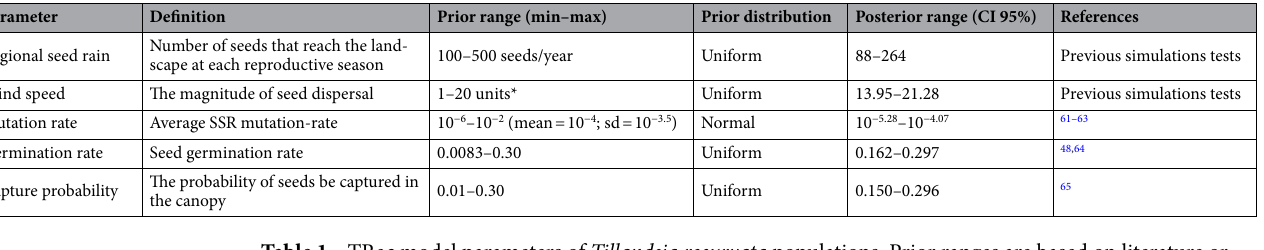
trees/ha (Fig. 5A). The simulations also showed a tendency of convergence in the proportion of ground cover (ca. 100%; Fig. 5B) and MLL abundance of T. recurvata populations (ca. 140 MLLs; Fig. 5D) among such distinct scenarios after the first 60 years following the tree density changes. Populations from deforested and reforested landscapes, however, showed distinct patterns of individual abundance (Fig. 5C). While T. recurvata populations from deforested landscapes increased up to ca. 600,000 individuals between the 30th and the 60th year, popula- tions from reforested landscapes shrank up to 35% of individuals from the 45th year onwards. The differences in the number of individuals per MLL (Fig. S6) resulted in reducing SGS over time in populations from deforested landscapes and an increasing SGS over time in populations from reforested landscapes (Fig. 5E). Compared to the low and moderate tree density changes, the scenario with a massive loss of 90% of trees led to a particularly weaker increment of individuals (Fig. 5C). Such increment resulted in individual abundances closer to that observed in reforested landscapes, but with a lower mean number of alleles per subpopulation (A; Fig. 5F).